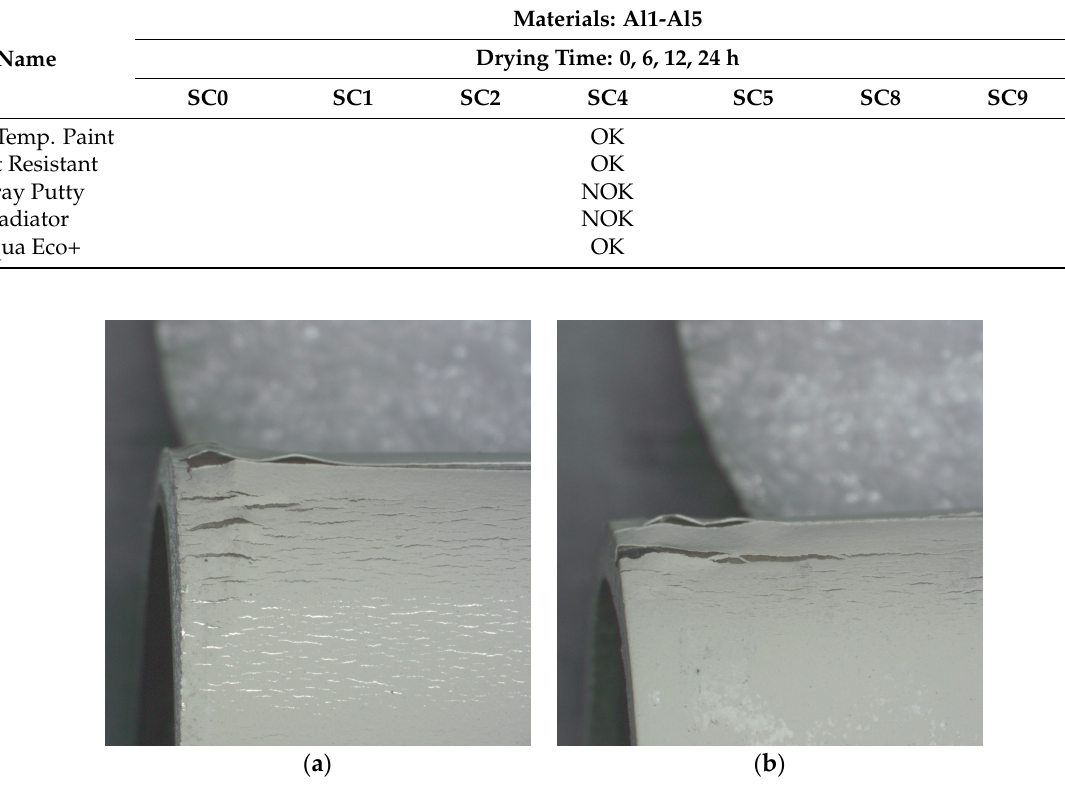
Figure 2. Microscopic images of paints. ( a ) P5’s and ( b ) P8’s.